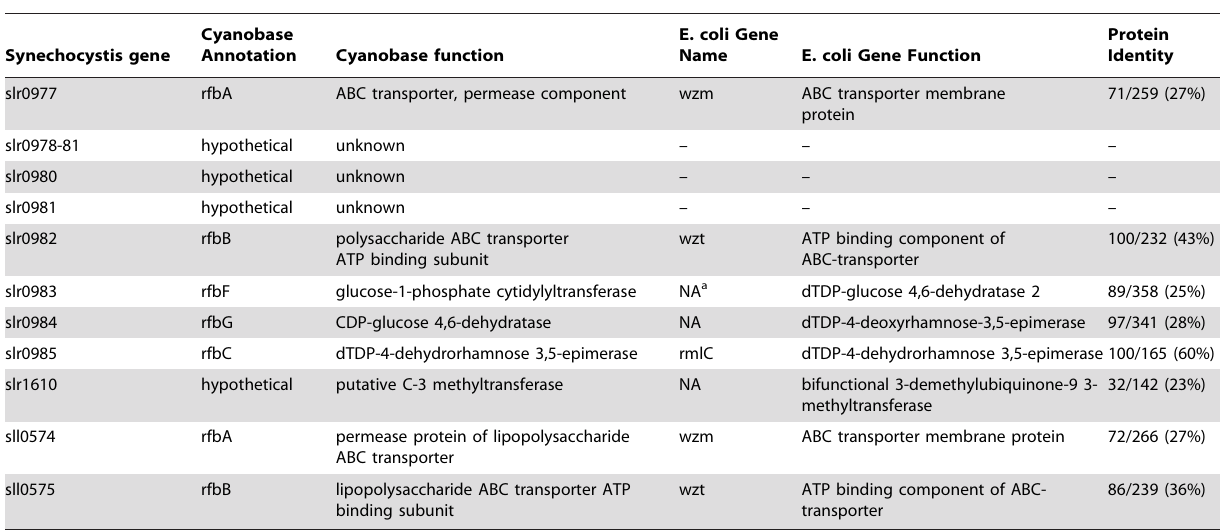
Table 2. Bioinformatic analysis of the slr0977 gene cluster.